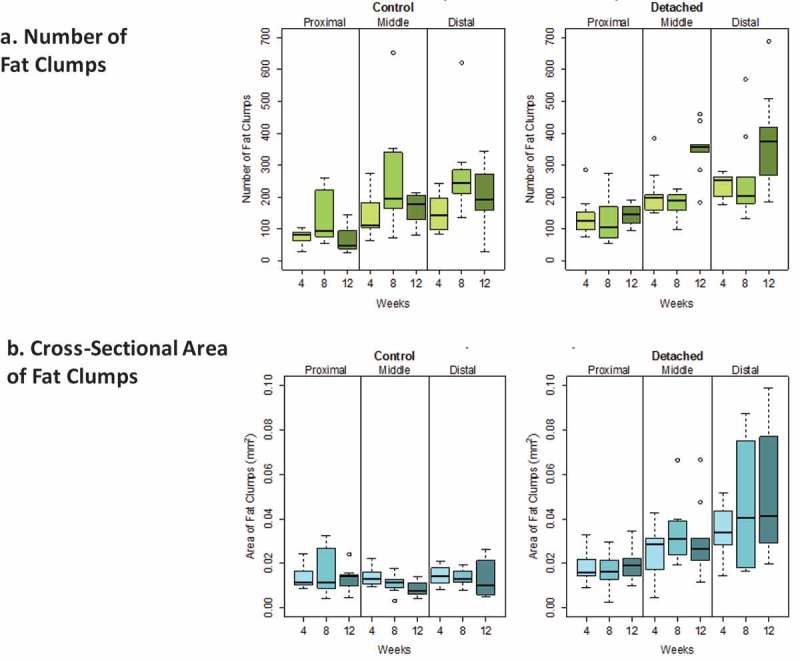
Boxplots showing the distribution of intramuscular fat clump numbers (a) and cross-sectional area (b) (mm2) for SSP tendons detached for 4, 8 and 12 weeks and for age-matched controls. Horizontal lines in the boxes represent the median values, limits of the boxes represent upper and lower quartiles, lines extending vertically from boxes represent variability outside the boxes and outliers are plotted as individual points. The dispersion of the number of fat clumps was similar for both detached and controls. A large variability in the fat clump cross-sectional areas was observed for the detached group in the distal quarter at 8 and 12 weeks after detachment and displayed in the large sizes of the boxes for these two groups compared to controls.